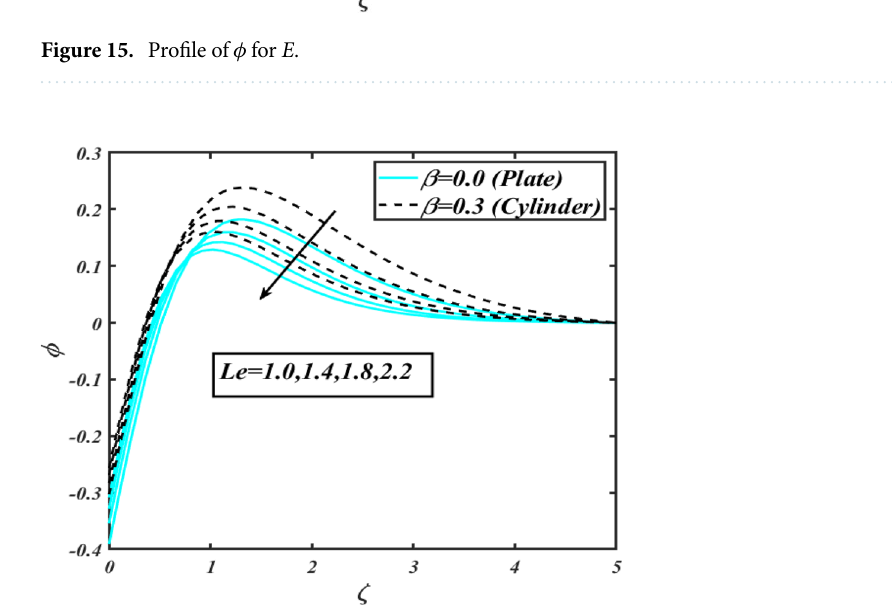
Figure 16. Profile of φ for Le